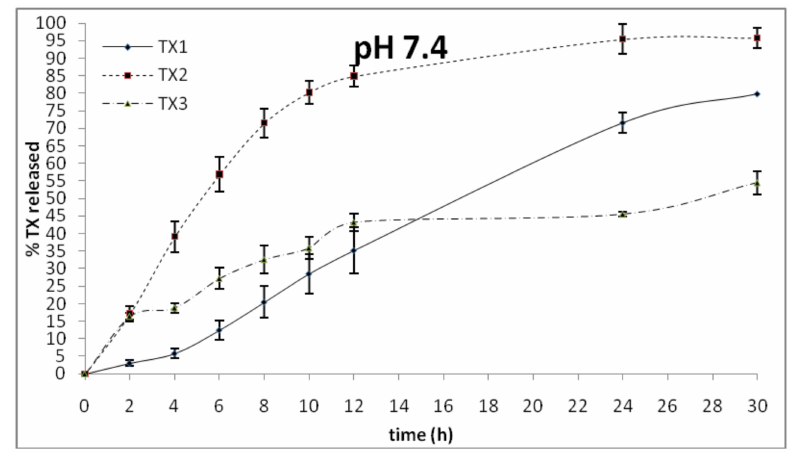
Figure 5. The TX release profiles at pH 7.4.